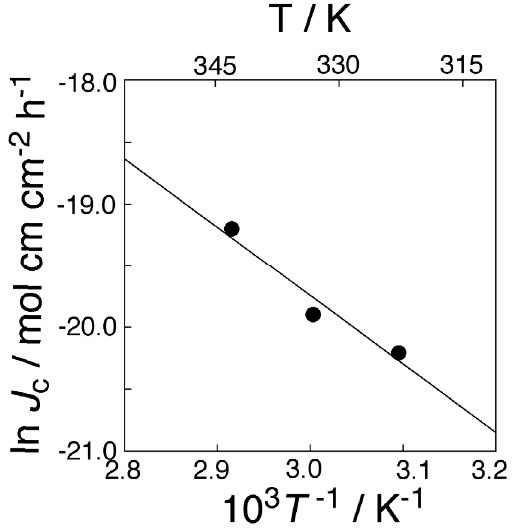
Figure 6. Temperature dependence of KCl transport through the PC18AAm liquid